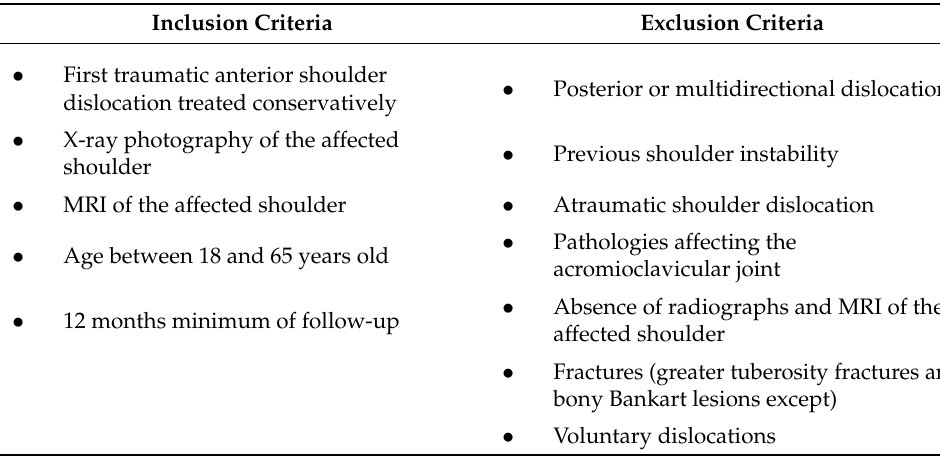
Table 1. Inclusion and exclusion